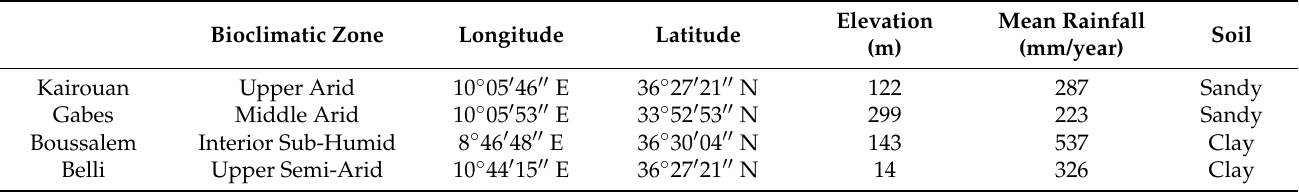
Table 1. Studied area data of Tunisian lemon